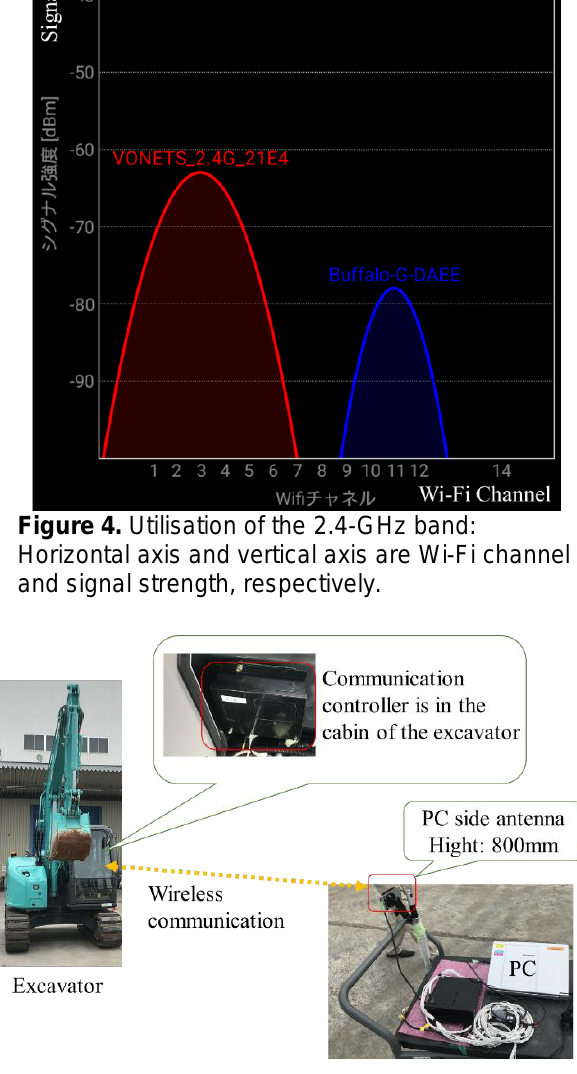
Figure 5. Experimental environment. The PC and the communication controller communicate using IEEE802.11